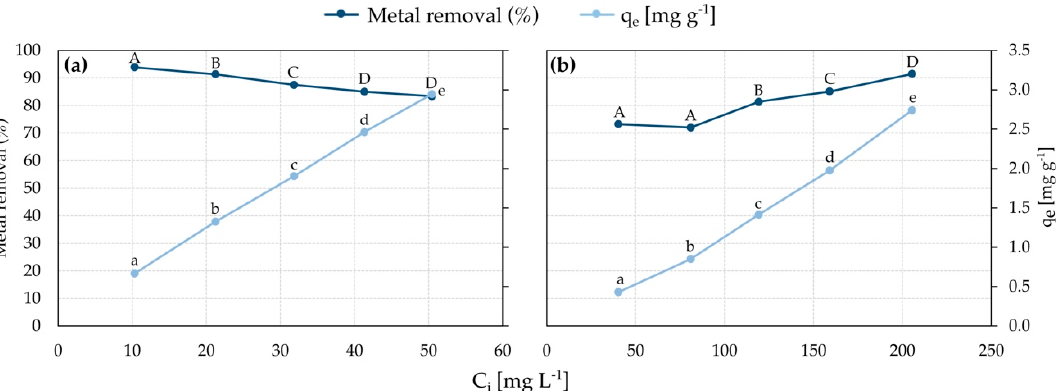
Figure 7. Effect of the initial metal concentration on biosorption capacity and removal of Ni 2+ (a) by S. plymuthica strain SC3I(2) and Cu 2+ (b) by S. plymuthica strain As3-5a(5) (SC3I(2) amount of biomass, 2.73 × 10 10 cell mL − 1 ; As3-5a(5) amount of biomass 7.43 x 10 10 cell mL − 1 ; temperature, 24 °C; agitation rate, 100 rpm; contact time, 30 min). Letters indicate whether the values differ significantly according to Tukey’s test ( p <